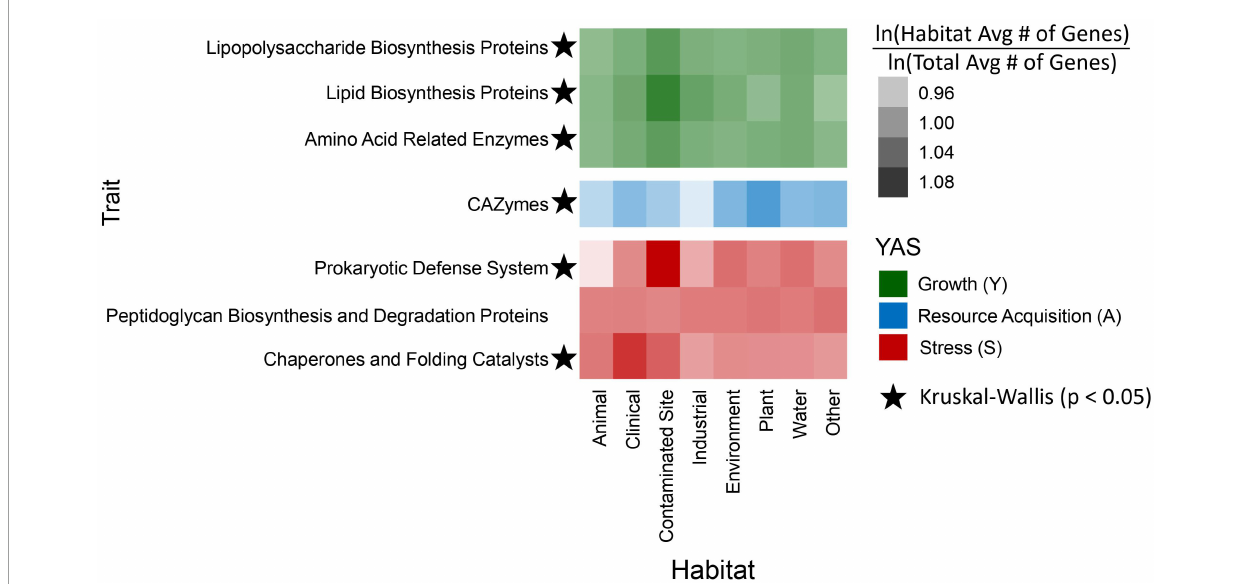
FIGURE4 Heatmap depicting the enrichment of genome-based traits by habitat. Each heatmap box was calculated by taking the natural log of the average number of genes within a habitat for a specific trait and dividing it by the natural log of the total gene average in all habitats for the same trait. Traits are grouped together based on their Y-A-S classification: top green rows are growth traits, the middle blue CAZymes row is a resource acquisition trait, and the bottom, red rows are stress tolerance traits. Traits with stars indicate significant (Kruskal–Wallis, p < 0.05) differences of natural log transformed gene counts between